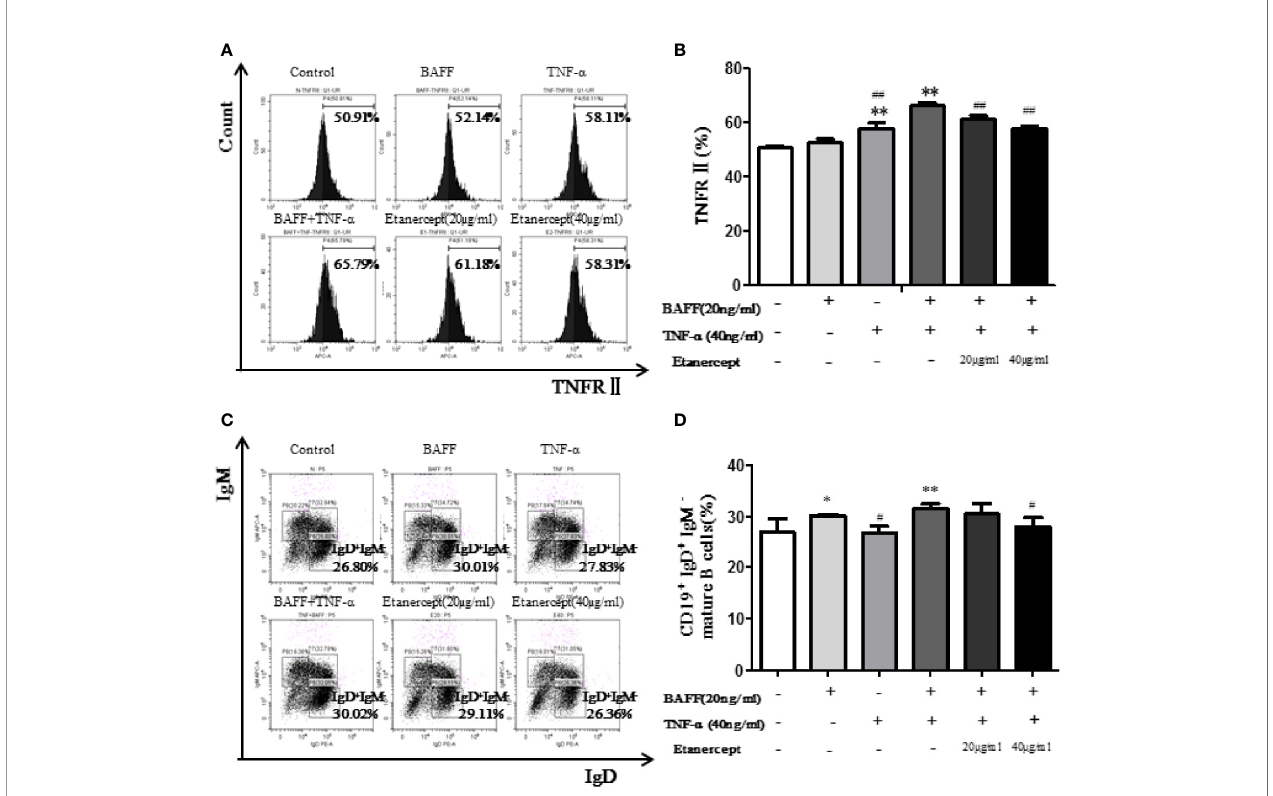
FIGURE 6 | Etanercept inhibits the transition of transitional B cells to mature B cells. (A) The representative fl ow cytometry graphs of TNFRII expression on type II transitional B cells in different groups. (B) The expression of TNFRII on type II transitional B cells IS compared between different groups. (C) The representative fl ow cytometry graphs of mature B cells ’ percentage in different groups. (D) Percentage of mature B cells was compared between different groups. * p < 0.05 vs Control group, ** p < 0.01 vs Control group, # p < 0.05 vs BAFF+TNF- a group, ## p < 0.01 vs BAFF+TNF- a